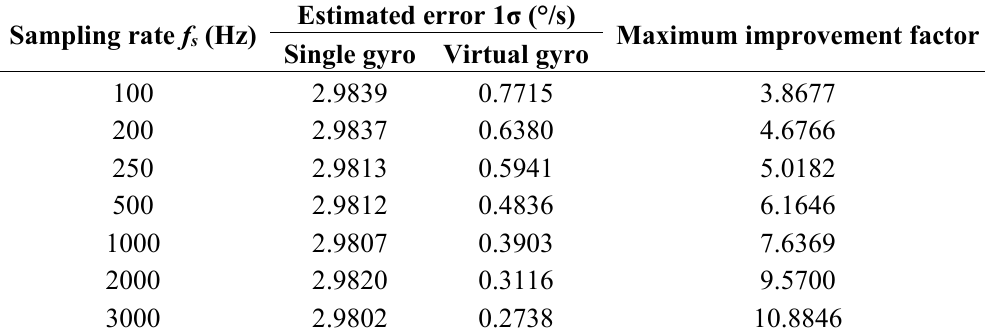
under different ω